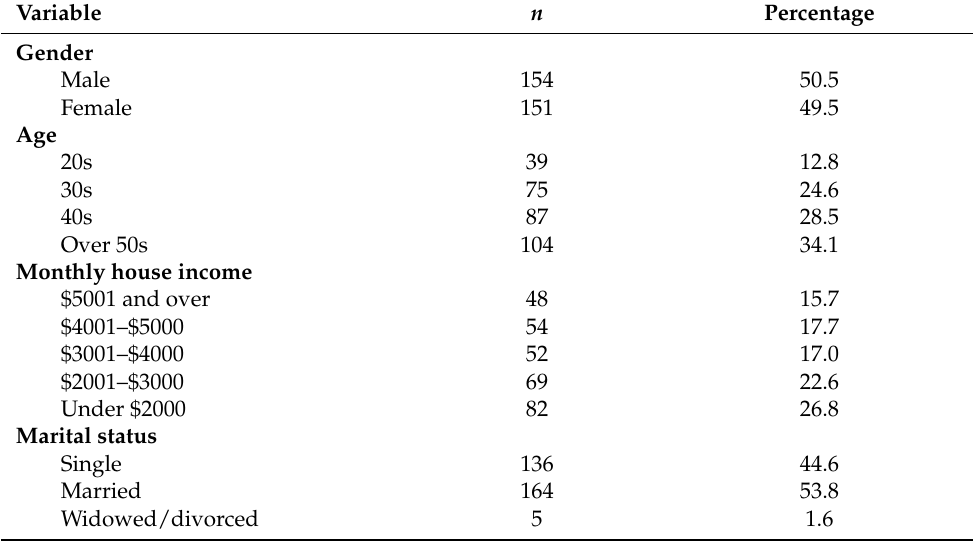
Table 1. Profile of survey respondents ( n =